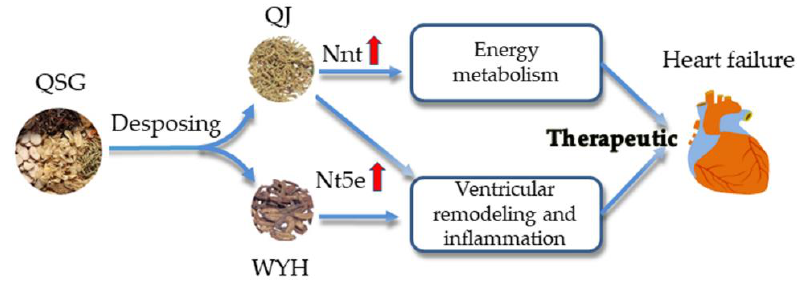
Figure 5. The effects of the decomposed recipes (QJ and WYH) of QSG on heart failure. By studying the decomposed QSG, we found that the two decomposed recipes were therapeutic to heart failure. QJ affects the energy metabolism through Nnt-mediated mechanisms, while QJ and WYH both affect ventricular remodeling and inflammation reactions through Nt5e-mediated mechanisms.